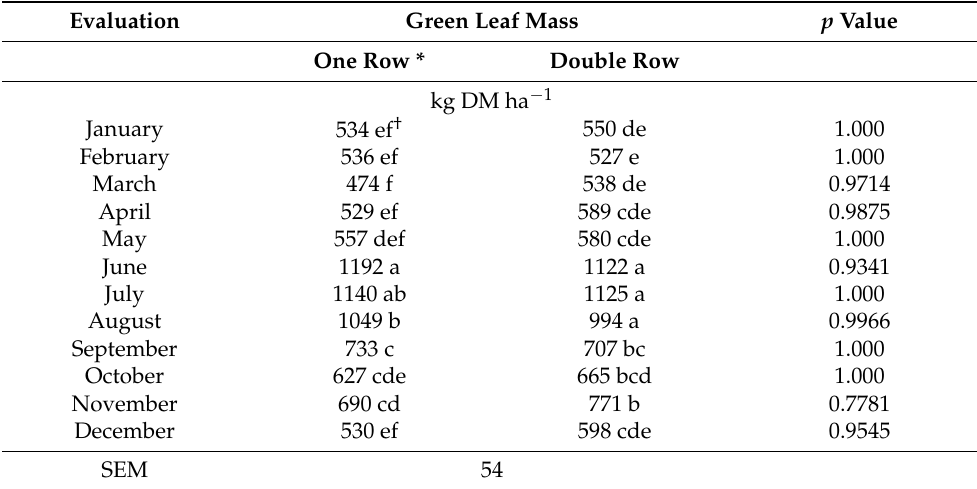
Table 2. Green leaf blade in one-row and in double-row during the experimental period. Evaluation Green Leaf Mass